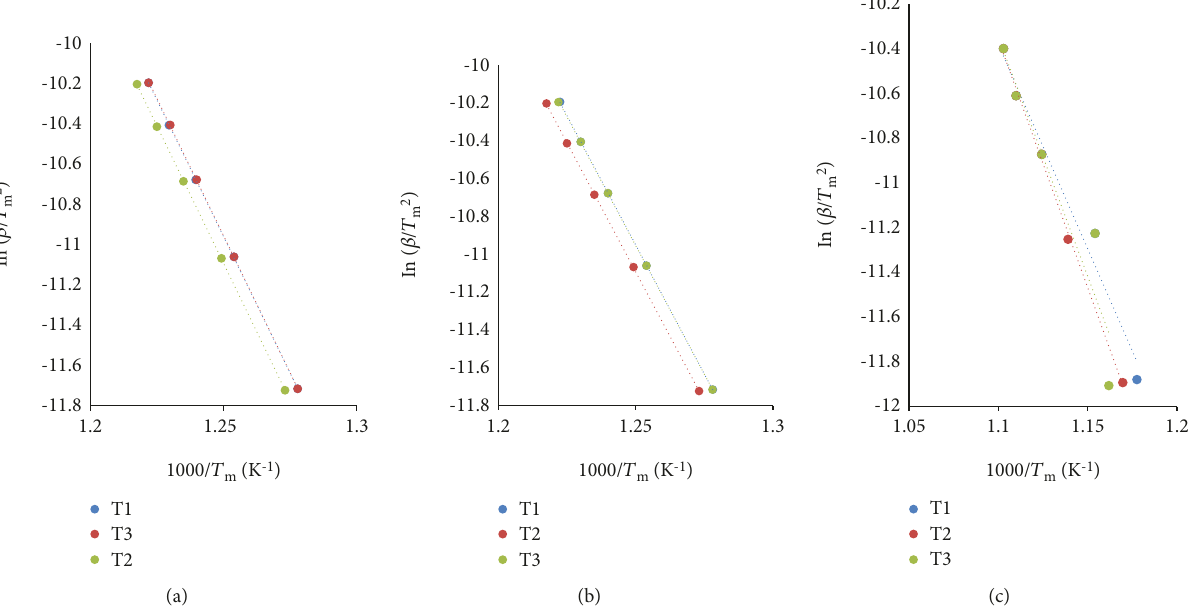
Figure 6: Determination of apparent activation energy ( E and (c) soil